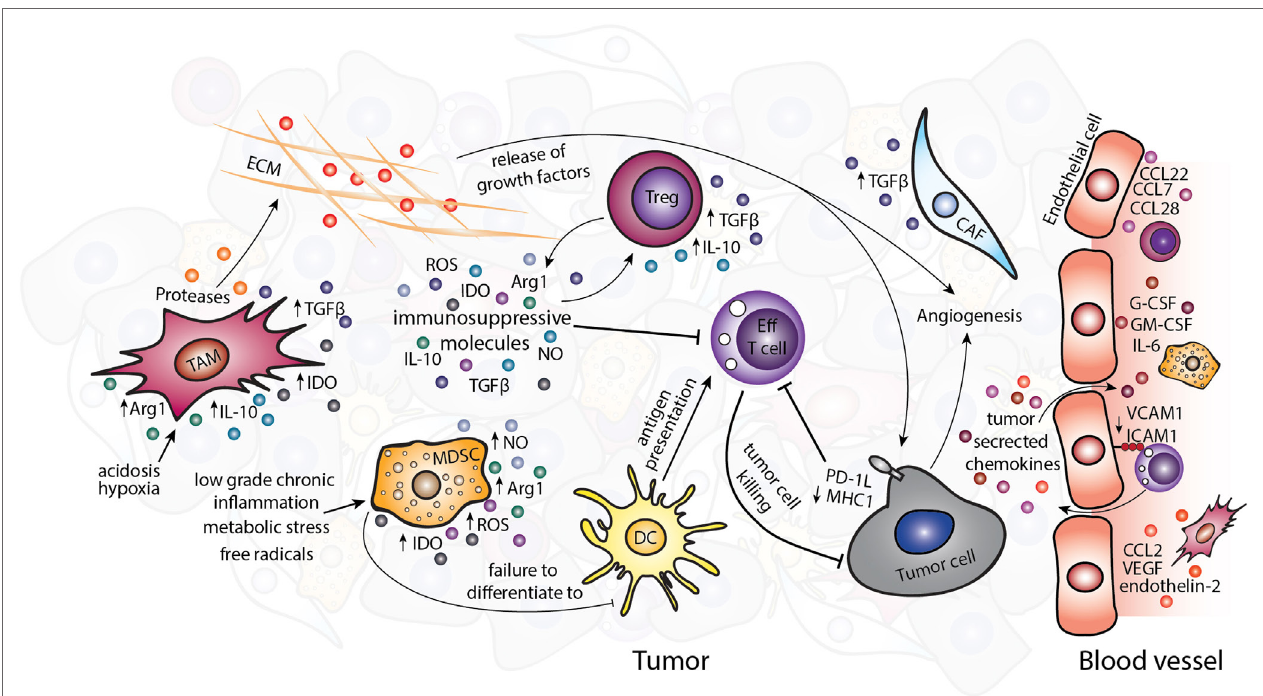
FigURe 1 | The immunosuppressive tumor microenvironment. Various immunosuppressive cell types exist within the TME including TAMs, MDSCs, Tregs, and CAFs. Tumor-derived chemokines and the metabolic tumor environment recruit or polarize these cells to a protumor, immunosuppressive phenotype. Suppression of the antitumor immune response occurs partly through the release of immunosuppressive molecules such as TGF- β , IL-10, IDO, Arg1, ROS, and NO. Abbreviations: Arg1, arginase1; CAFs, cancer-associated fibroblasts; DC, dendritic cell; ECM, extracellular matrix; Eff T cell, effector T cell; IDO, idoleamine 2,3-dioxygenase; MDSCs, myeloid-derived suppressor cells; ROS, reactive oxygen species; NO, nitric oxide; TAMs, tumor-associated macrophages; Tregs, regulatory T